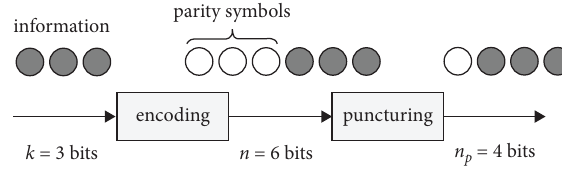
Figure 6: Te example of the puncturing process at the transmitter.